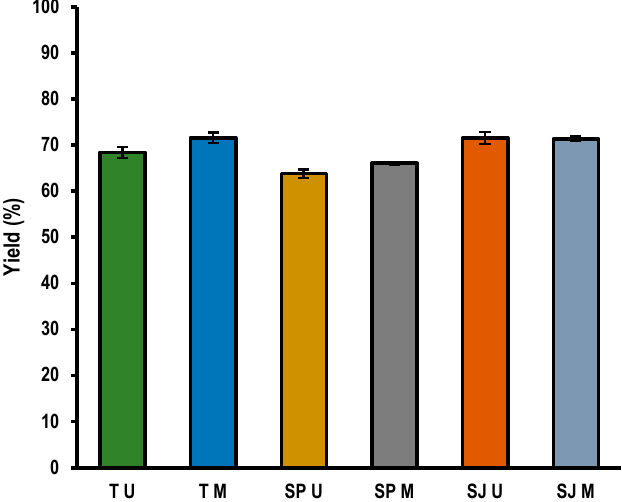
Figure 1. Yield in propolis extracts, from three places and two extraction methods. (T U = Teotitlán de Flores Magón, Ultrasound; T M = Teotitlán de Flores Magón, Maceration; SP U = San Pedro Ocopetatillo, Ultrasound; SP M = San Pedro Ocopetatillo, Maceration; SJ U= San Jerónimo Tecóatl, Ultrasound; SJ U = San Jerónimo Tecóatl, Maceration). Table 2. Behavior of total phenols during the in vitro digestion of different propolis